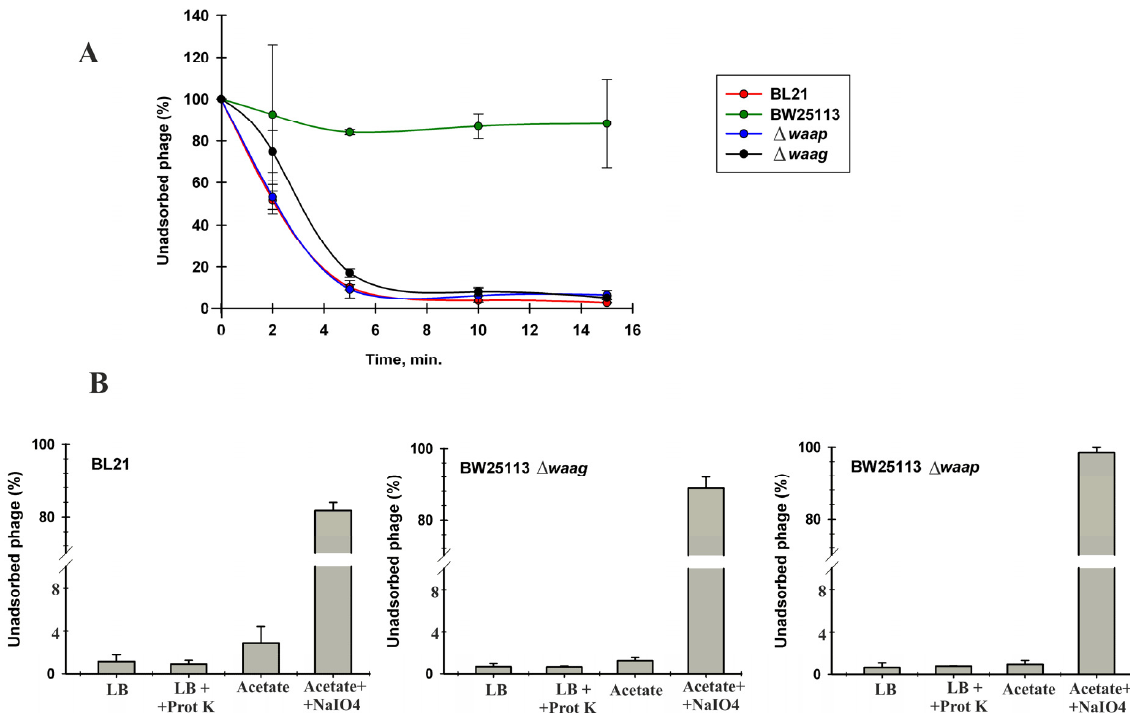
Figure 8. VpaE1 adsorption assays: ( A ) VpaE1 adsorption kinetics; and ( B ) effect of proteinase K, sodium acetate and periodate treatment on the ability of VpaE1 to adsorb to E. coli BL21, BW25113 Δ waaG and Δ waaP .